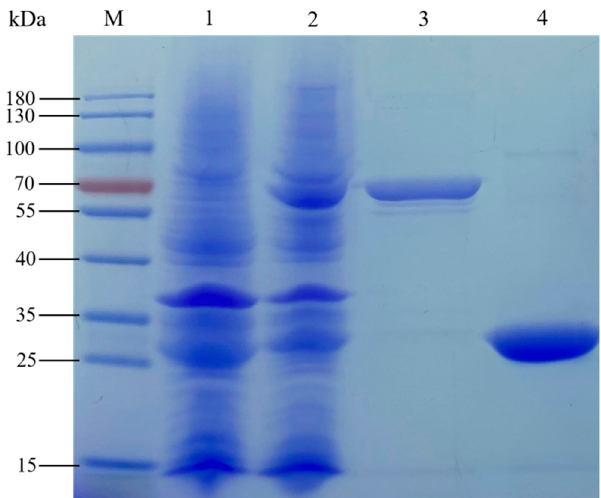
Figure 11. Prokaryotic expression protein analysis of BoGAPC protein. Lane 1 is uninduced pGEX- 4T-1-BoGAPC protein, lane 2 is induced unpurified pGEX-4T-1-BoGAPC protein, lane 3 is induced purified pGEX-4T-1-BoGAPC protein and lane 4 is induced purified empty protein.